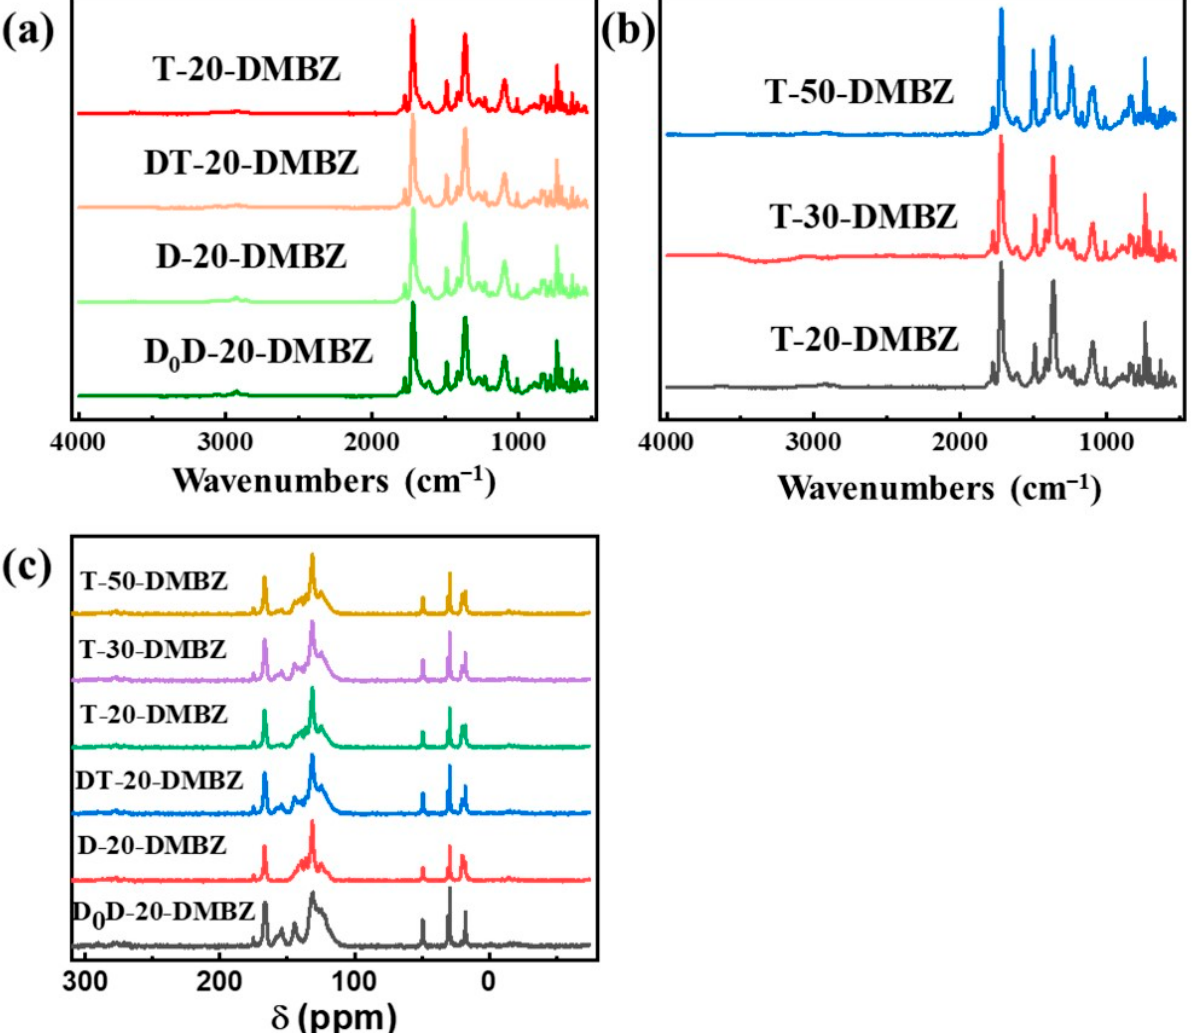
Figure 2. ( a ) Fourier transform infrared (FT-IR) spectra of aerogels cross-linked with silicone poly- mers prepared from different precursors; ( b ) Fourier transform infrared (FT-IR) spectra of aerogels cross-linked with silicone polymer of different degrees of polymerization; ( c ) 13 C Solid NMR